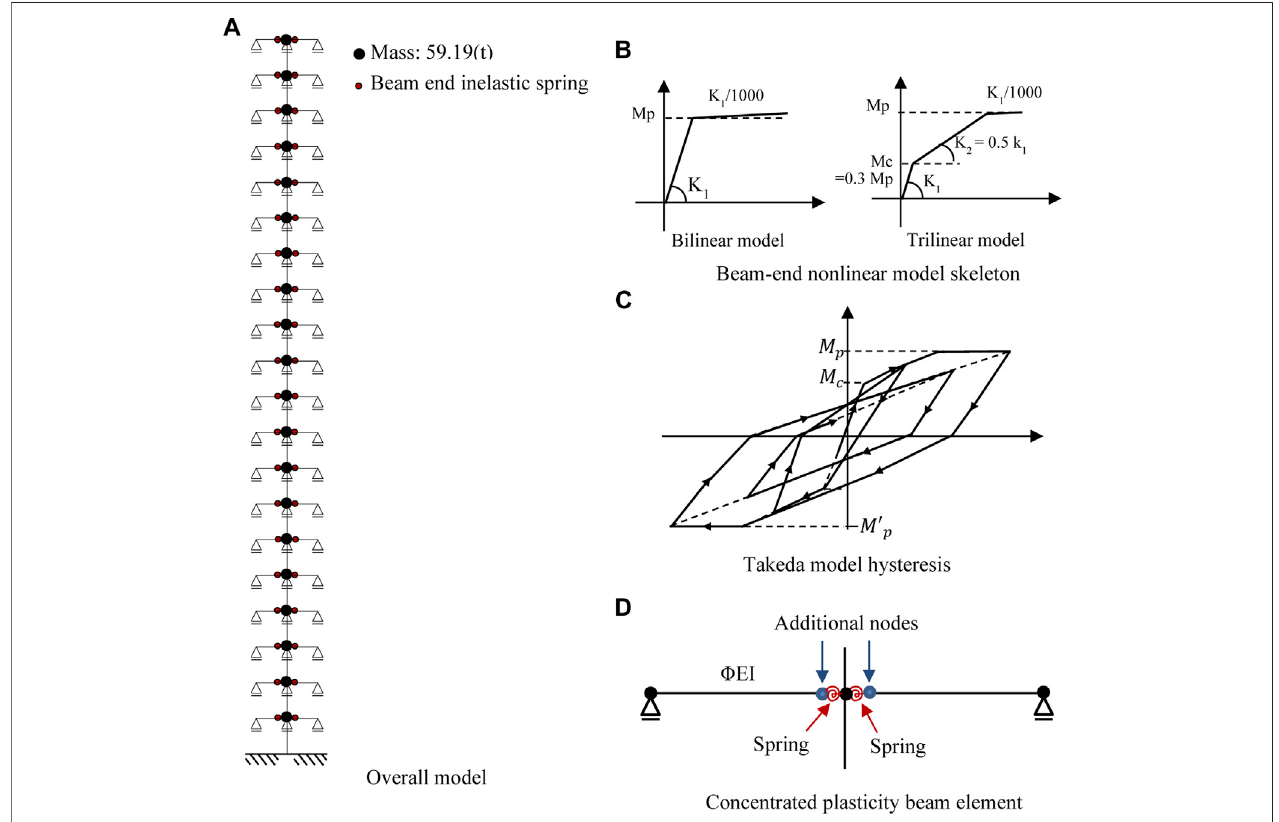
FIGURE4|(A) Overallviewofthe20-story fi shbonemodel, (B) beam-endnonlinear modelskeleton, (C) Takedamodelhysteresis,and (D) concentratedplasticity beam